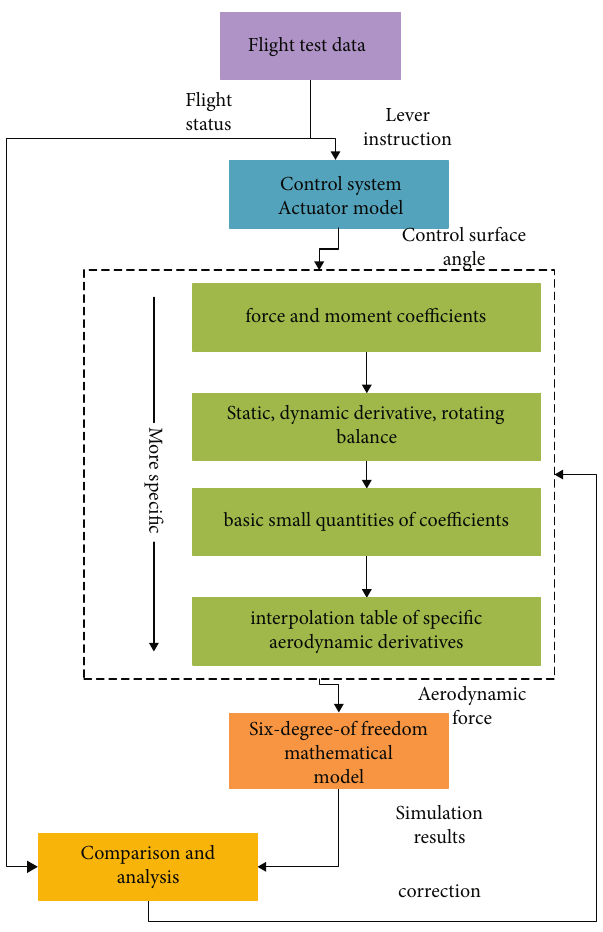
Figure 7: Flowchart and data direction of the homology comparison method and modeling; green boxes indicate the aerodynamic data hierarchy. Figure